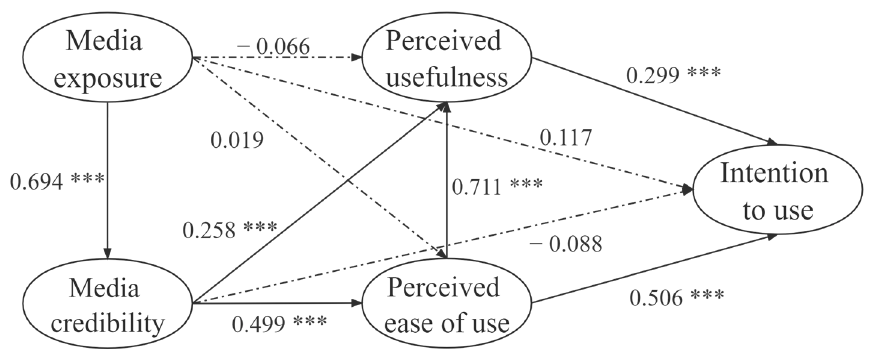
Figure 1. Results from the structural equation modeling procedure for the final model: values indicate standardized regression weights and the path load factor. Notes: *** p < 0.001, t > 3.29.